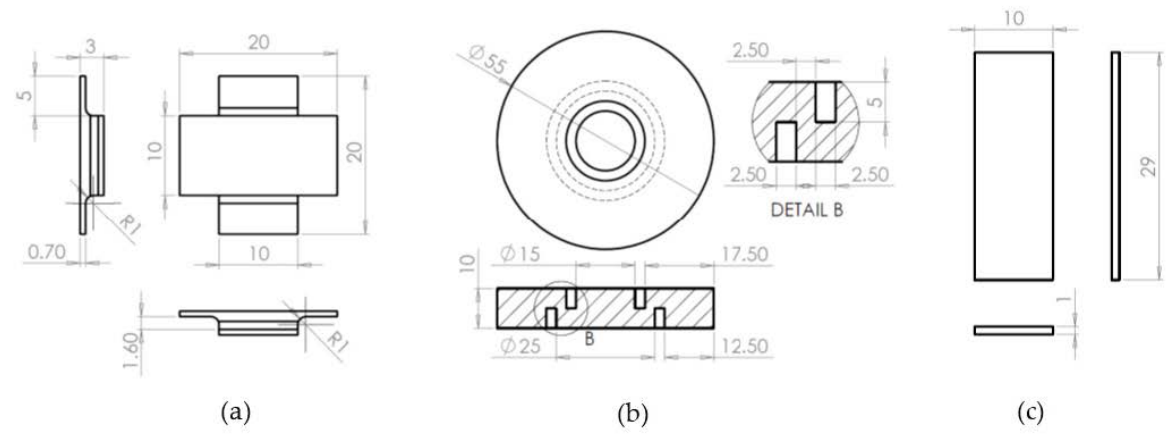
Figure 1. Engineering drawings of indirect geometries. ( a ) waisted cruciform, ( b ) cylindrical punch-out, and ( c ) flexural three-point bend.